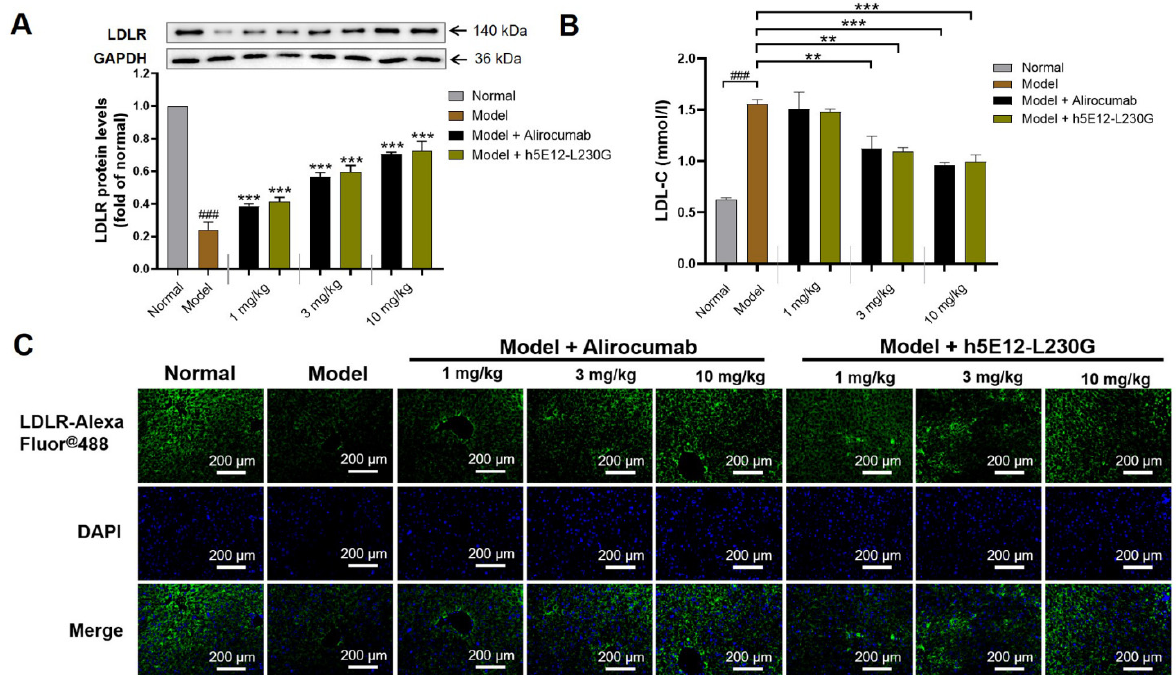
Figure 7. In vivo hypolipidemic efficacy of h5E12-L230G in hypercholesterolemic model mice. ( A ) Hepatic LDLR changes in h5E12-L230G or alirocumab treated C57BL/6 mice were detected by Western blot. ### p < 0.001 vs. Normal group. ** p < 0.01, *** p < 0.001 vs. Model group. ( B ) h5E12-L230G demonstrated a significant dose-dependently LDL-C lowering effect similar to alirocumab. Results were expressed as mean ± SEM ( n = 6 per group). See Table 1 for detailed value. ( C ) Hepatic LDLR changes in h5E12-L230G or alirocumab treated C57BL/6 mice were detected by Immunofluorescence. Scale bars = 200 μ m. Data are representative of 3 independent experiments with similar results. Table 1. Effects of h5E12-L230G on serum lipids levels in hyperlipidemic mice model.